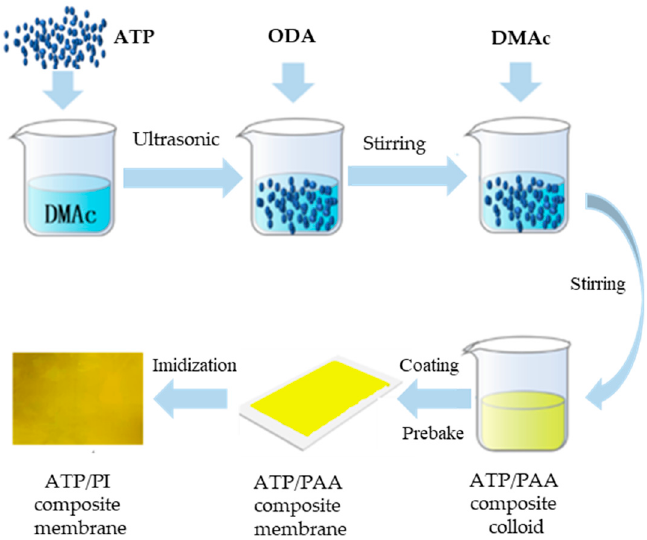
Scheme 1. The preparation flow chart of PI/ATP composite